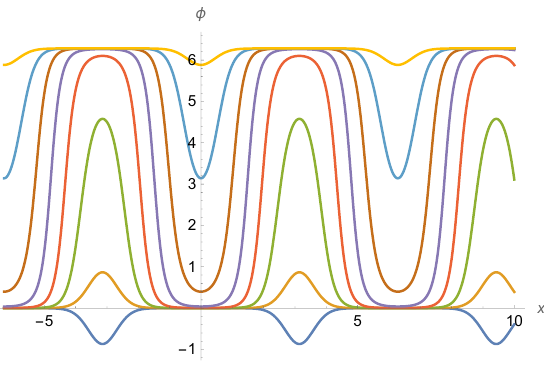
Figure 2 . Supersymmetric solutions of deformed SSG theory for m ( x ) = 5 sin x with β = 1 . From the top, c = 10 , 1 , 0 . 1 , 10 − 2 , 10 − 3 , 10 − 4 , and − 10 − 4 ,